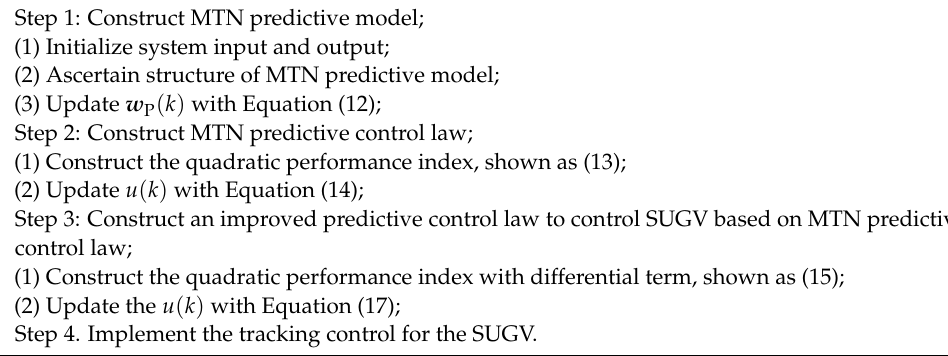
Algorithm 1 Scheme of MTN Predictive Control with the Differential